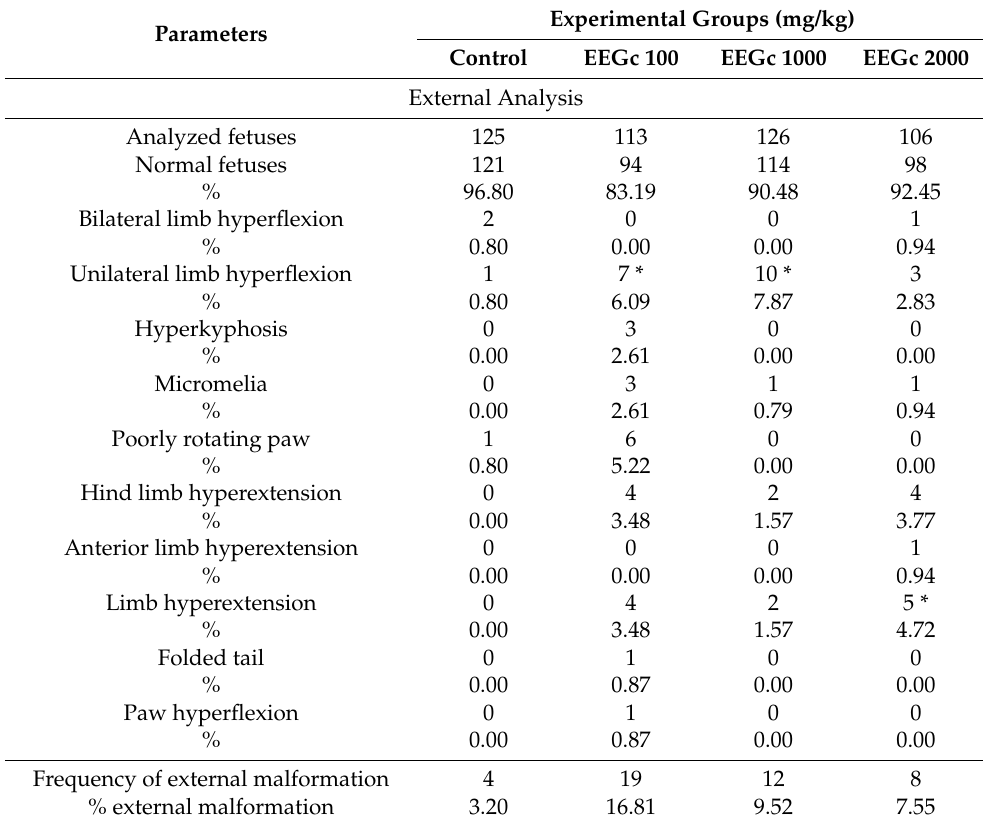
Table 4. External malformations found in the offspring of females treated with the G. celosioides ethanolic extract (EEGc).